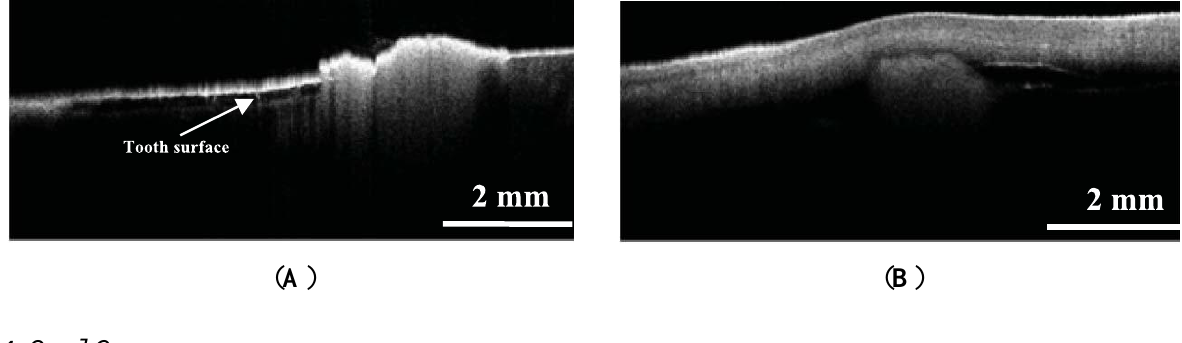
Figure 12. OCT image of subgingival calculus. ( A ) Subgingival calculus without coverage of gingiva. ( B ) Subgingival calculus covered with gigniva (reprinted from reference